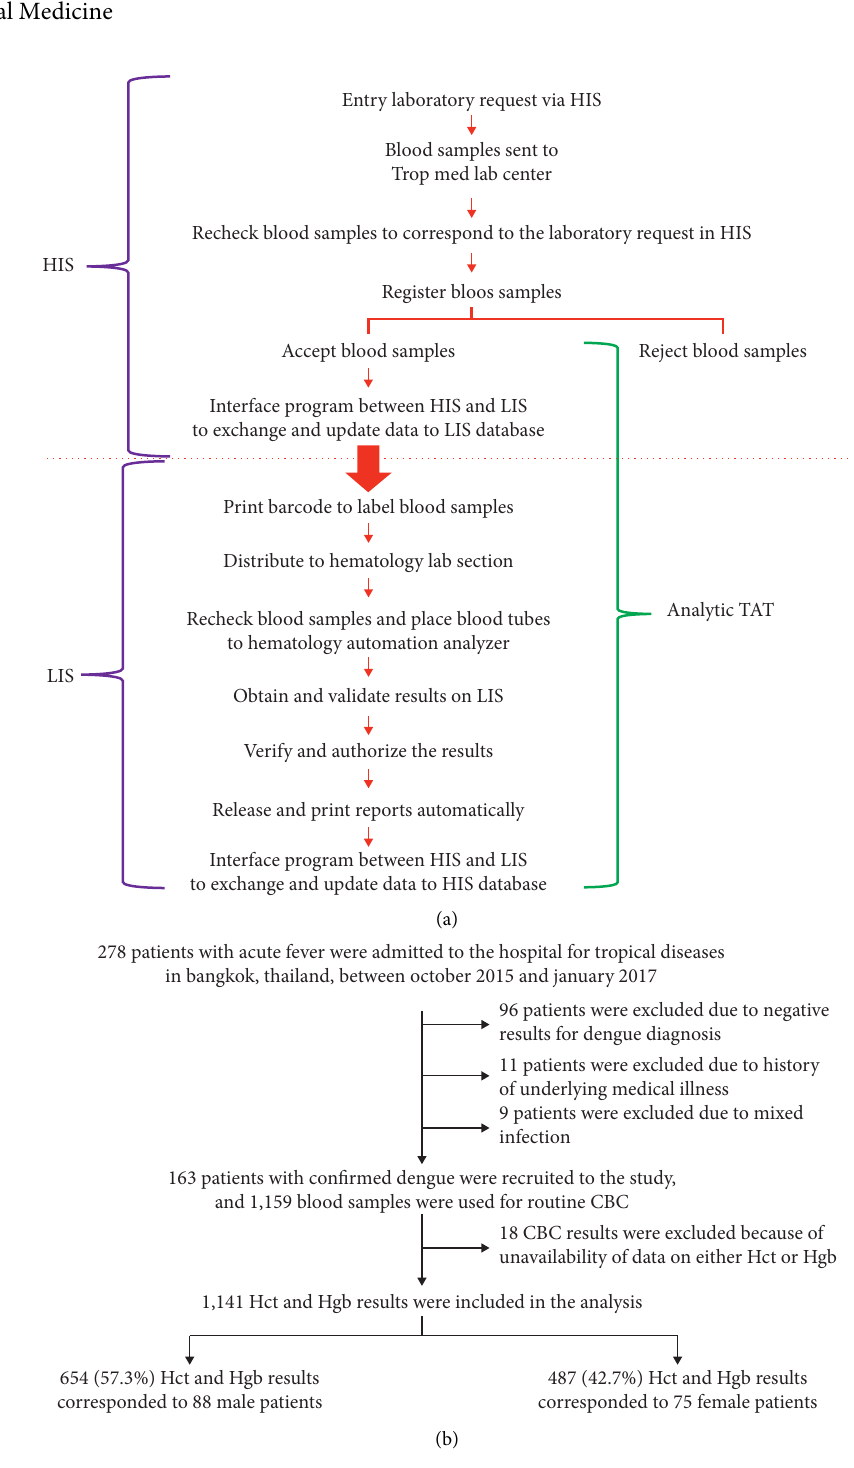
Figure 1: Flow diagram of (a) the study system and (b) patient